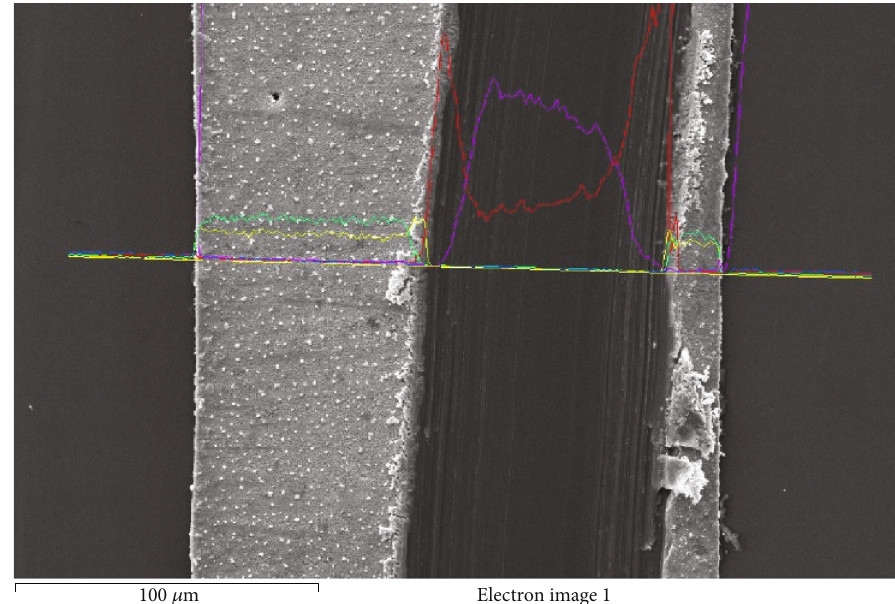
Figure 3: SEM analysis in a longitudinal section at a resolution of 100 μ m.